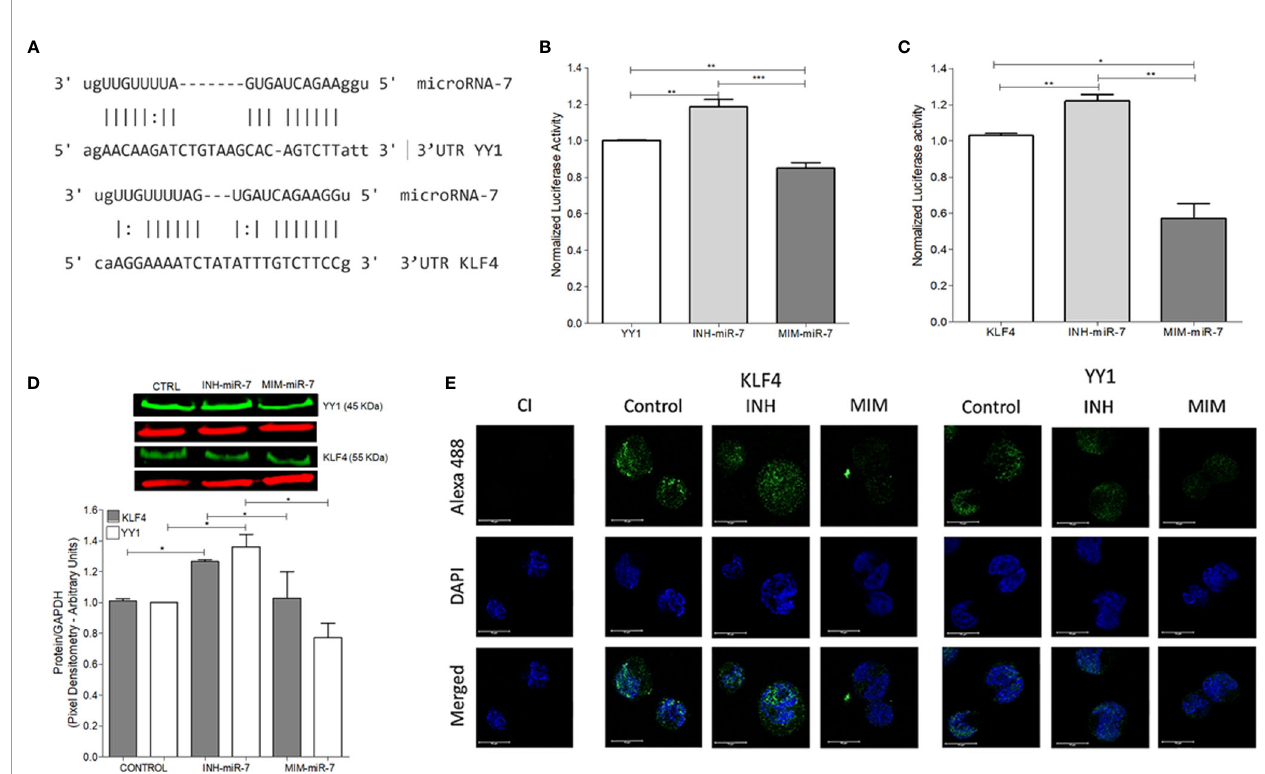
FIGURE 2 | miR-7 regulate the expression of YY1 and KLF4 by binding its 3`UTR region. (A) Analysis of miR-7 binding sites in the 3`UTR regions of KLF4 and YY1, through the miRtarbase database. (B) Raji cell line was previously co-transfected with an inhibitor (INH) or a mimic (MIM) of miR-7, and then transfected with the reporter plasmid with the luciferase gene containing the 3 ‘ UTR region of YY1 (B) and KLF4 (C) . The presence of INH for miR-7 increases the expression of KLF4 and YY1 (*** p < 0.001 ) and the MIM inhibits its expression (** p < 0.001 *p < 0.05 ), respectively. (D) Left: Western blot for KLF4 and YY1 was done, after treatment with an inhibitor or miR-7 mimic compared to a control. Right: densitometric analysis of YY1 and KLF4 expression was done and signi fi cant differences were indicated (* p < 0.05 ). (E) Immuno fl uorescence in Raji cell lines was done and expression of KLF4 and YY1 were evaluated after transfection with an inhibitor or miR-7 mimic. Representative images of a triplicate of each experiment are